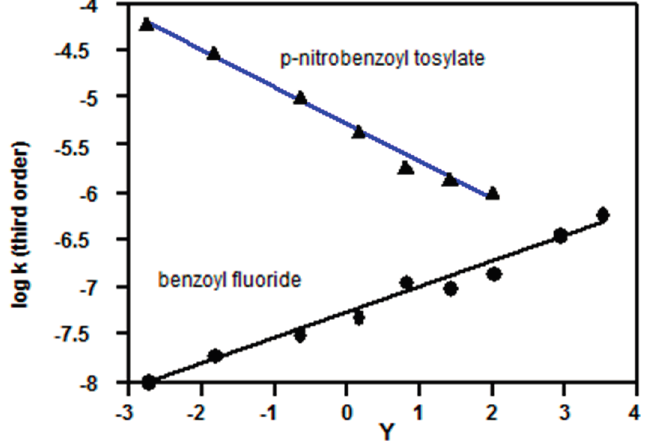
Figure 3. Plots of logarithms of third order rate constants (Equation (3)) vs. Grunwald-Winstein Y values [4,17] for acetone-water mixtures; kinetic data for benzoyl fluoride (3, Z = H) at 25 °C are from Reference [10]; kinetic data for p -nitrobenzoyl tosylate (4, Z = NO 2 ) at − 10 °C are from Reference